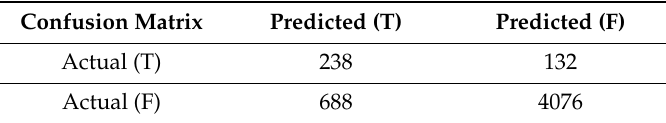
Table 2. Confusion matrix for our method.